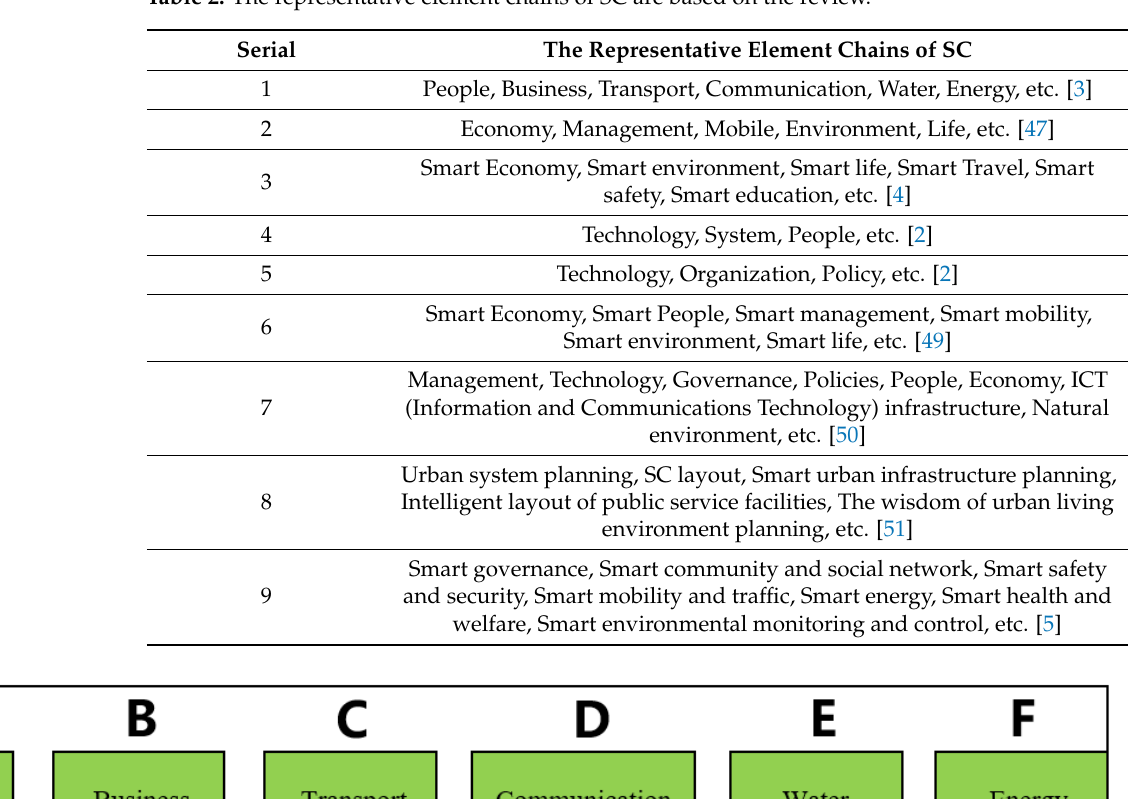
Table 2. The representative element chains of SC are based on the review.